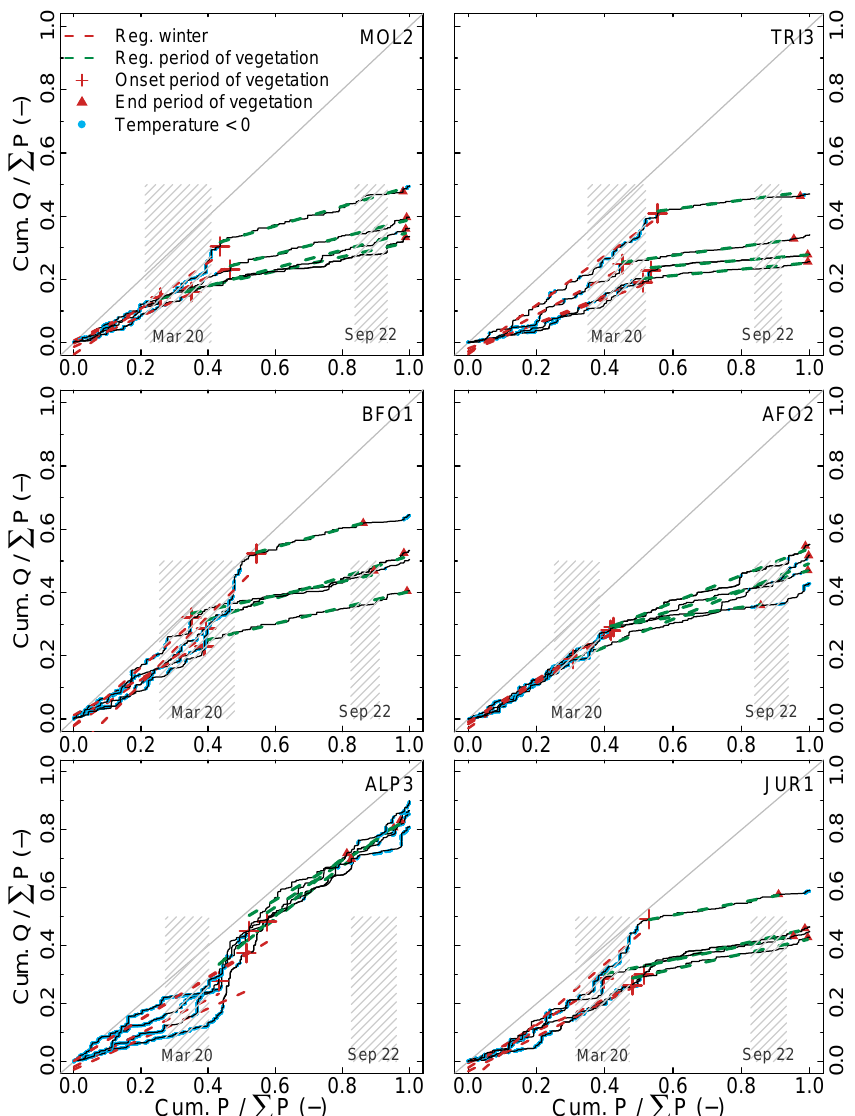
Figure 4. Type I dimensionless double mass curves for catchments of different geological units for the hydrological years 1999–2003. Onset and end of the period of vegetation are determined using a temperature-index model. Regression lines are fitted to both periods (dotted lines in red/green); their slopes are interpreted as seasonal runoff coefficients. Periods with temperatures < 0 ◦ C are highlighted in blue. Gregorian definitions for the first start of spring (20 March) and the last start of autumn (22 September) are added to the cum .P/ P P plane as hatched rectangles (to improve readability) to highlight their differences to temperature-based estimates at the onset and end of the period of vegetation. Statistical properties of the dDMC are summarized in Table